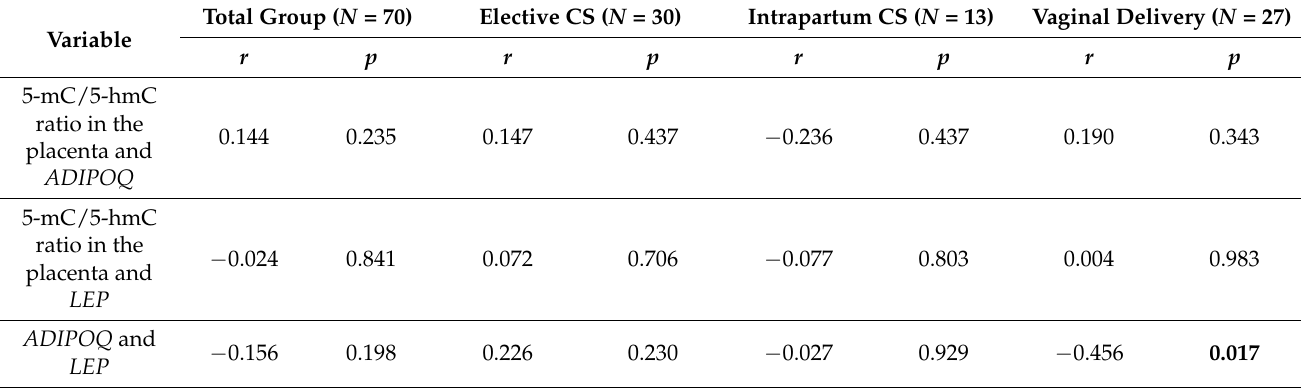
Table 6. Correlations between 5-mC/5-hmC ratio in the placenta and ADIPOQ and LEP demethylation index in the study